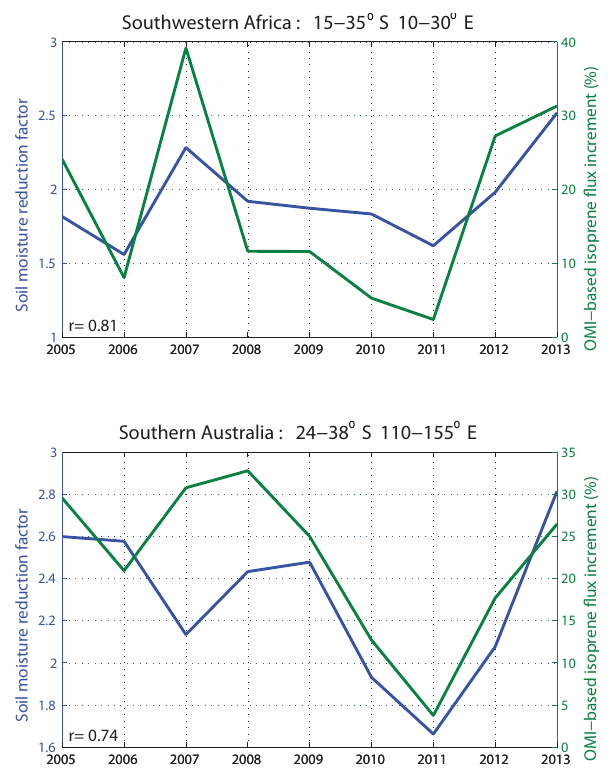
Figure 12. Interannual evolution of the factor by which the annual isoprene flux is reduced due to soil moisture stress vs. the iso- prene flux increment inferred from OMI data (in %) in southwest Africa (top) and southern Australia